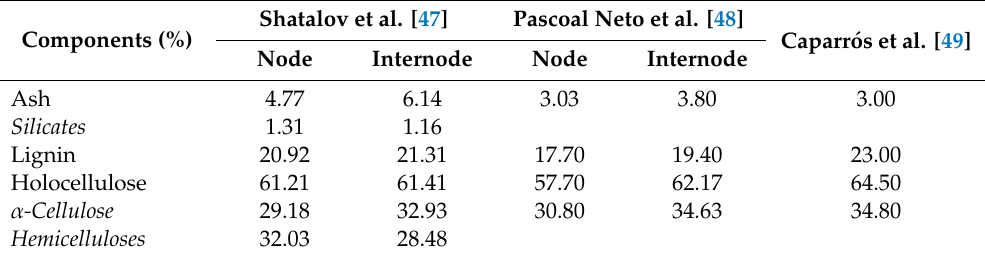
Table 1. Chemical composition of Arundo donax L. according to di ff erent authors. Shatalov et al. Components (%)